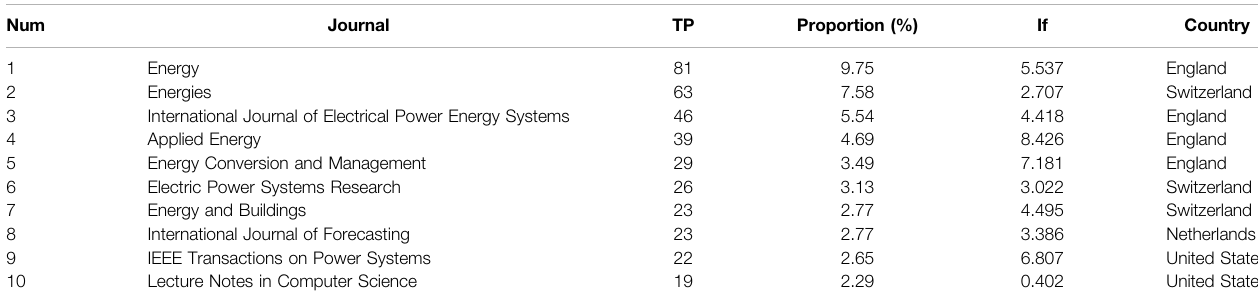
TABLE 1 | High-yield journals in electricity demand forecasting.